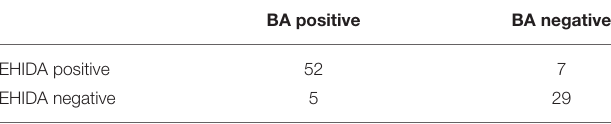
TABLE 1 | Correlation between EHIDA results and the